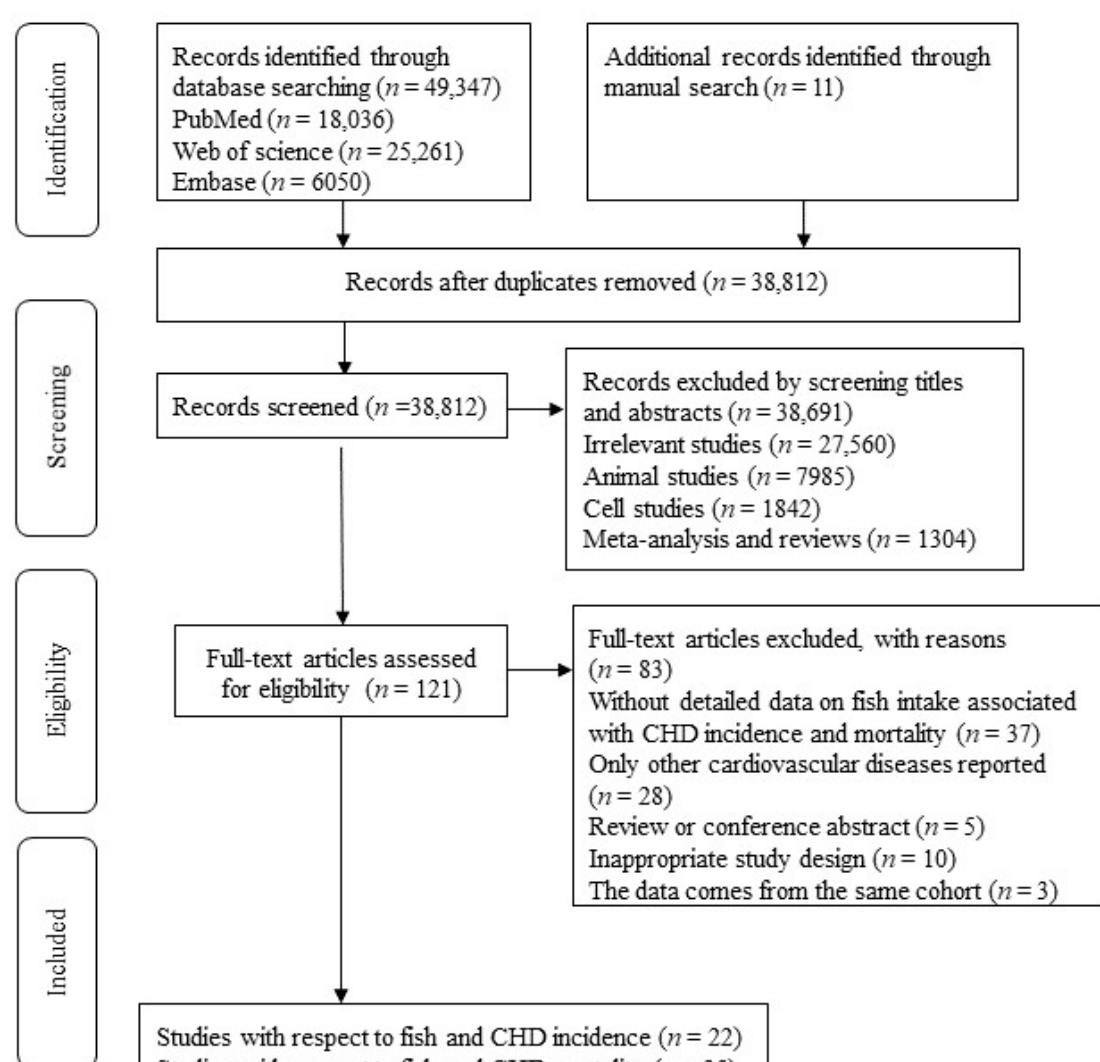
Figure 1. The flow chart for detailed steps of literature search.